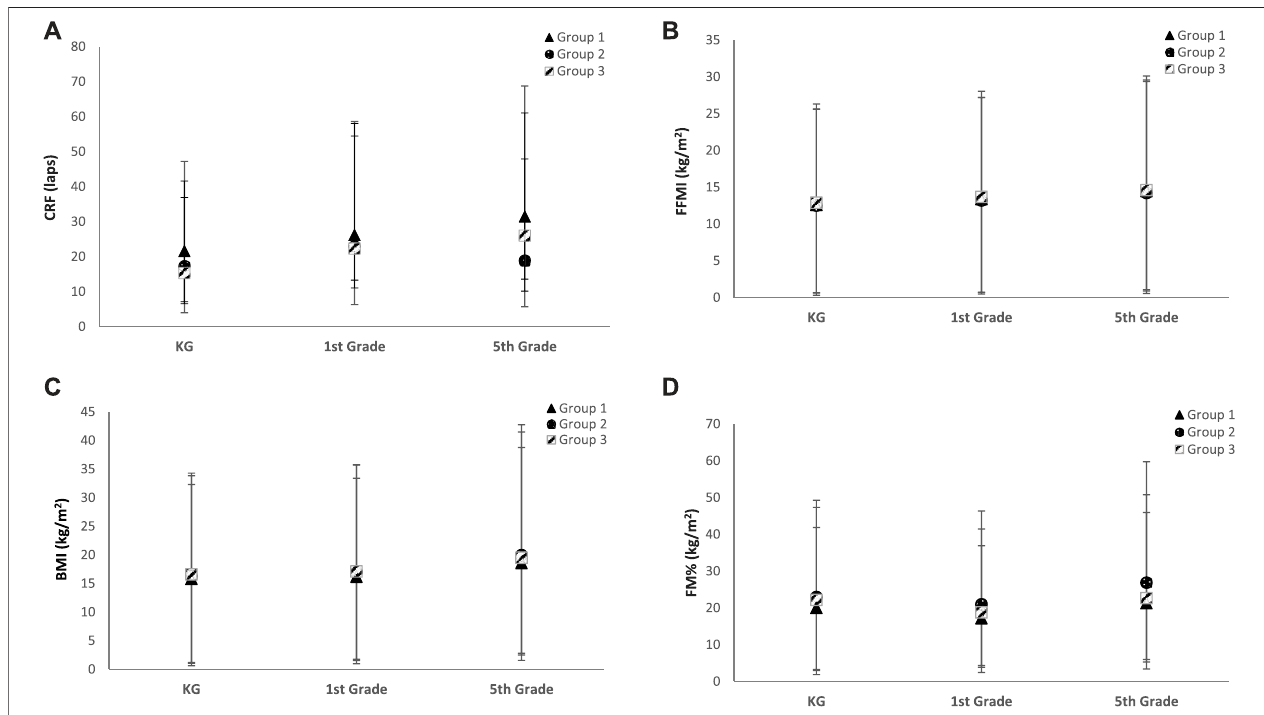
FIGURE1|(A) LongitudinalchangesinCRFindifferentgroupsaccordingtoorganizedsportsparticipation.Estimatedmarginalmeansexpressthenumberoflaps in the20-mshuttlerun. (B) LongitudinalchangesintheBMI indifferentgroups accordingtoorganized sportsparticipation. Estimated marginalmeansexpress thevalue oftheBMI. (C) LongitudinalchangesintheFFMIindifferentgroupsaccordingtoorganizedsportsparticipation.EstimatedmarginalmeansexpressthevalueoftheFFMI. (D) Longitudinal changes in the body fat % in different groups according to organized sports participation. Estimated marginal means express the percentage of body fat. Groups 1, 2, and 3: group 1 — participation in organized sports in all stages of the study; group 2 — never participated in organized sports; and group 3 — participation in organized sports in 5th grade or in 1st and 5th grades. CRF, cardiorespiratory fi tness; MVPA, moderate-to-vigorous physical activity; VPA, vigorous physical activity; BMI, body mass index (kg/m 2 ); FFMI, fat-free mass index (kg/m 2 ).